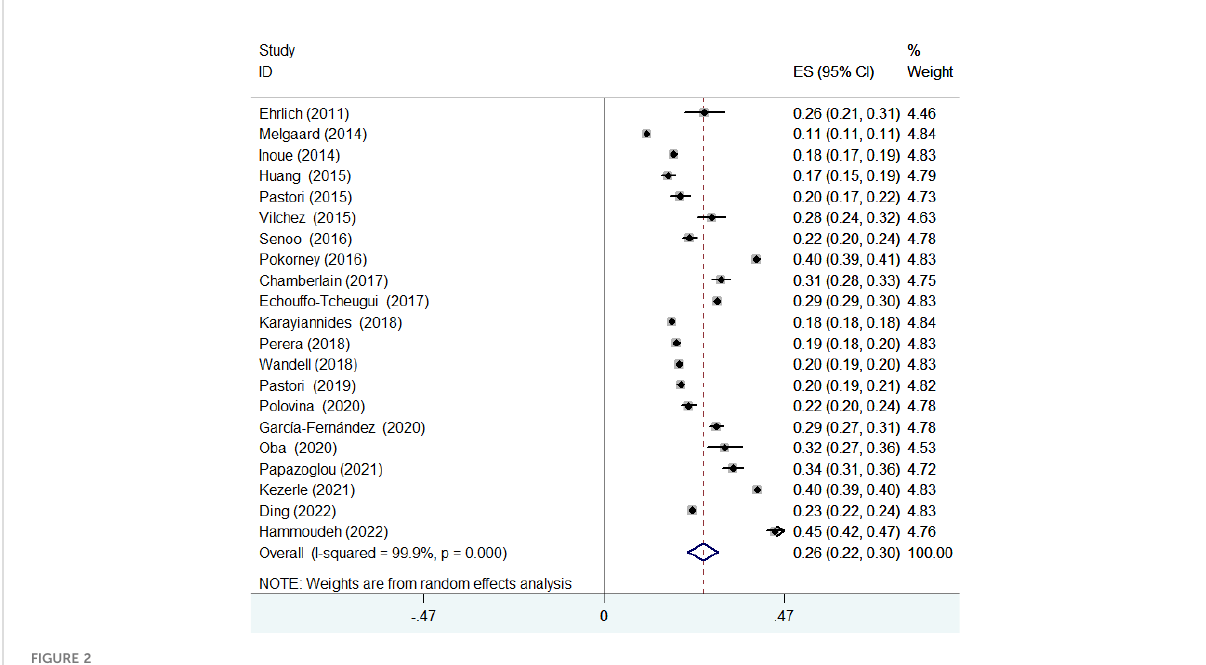
FIGURE 2 Pooled prevalence of diabetes mellitus in patients with atrial fi brillation.